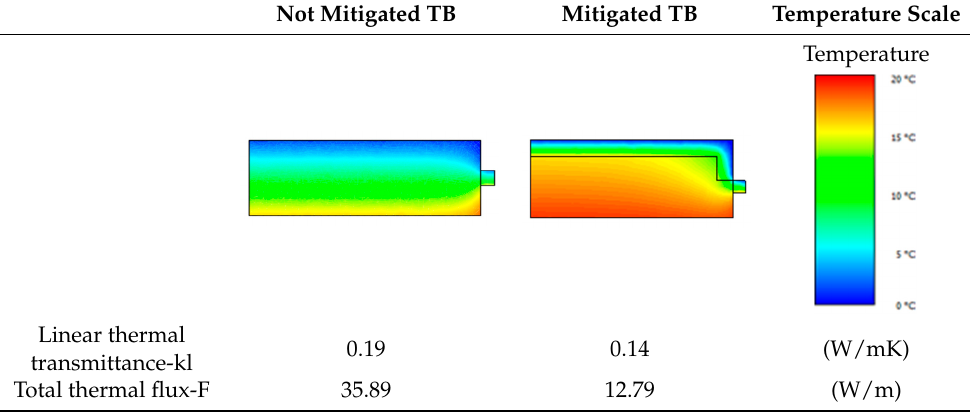
Table 10. W Thermal bridges.